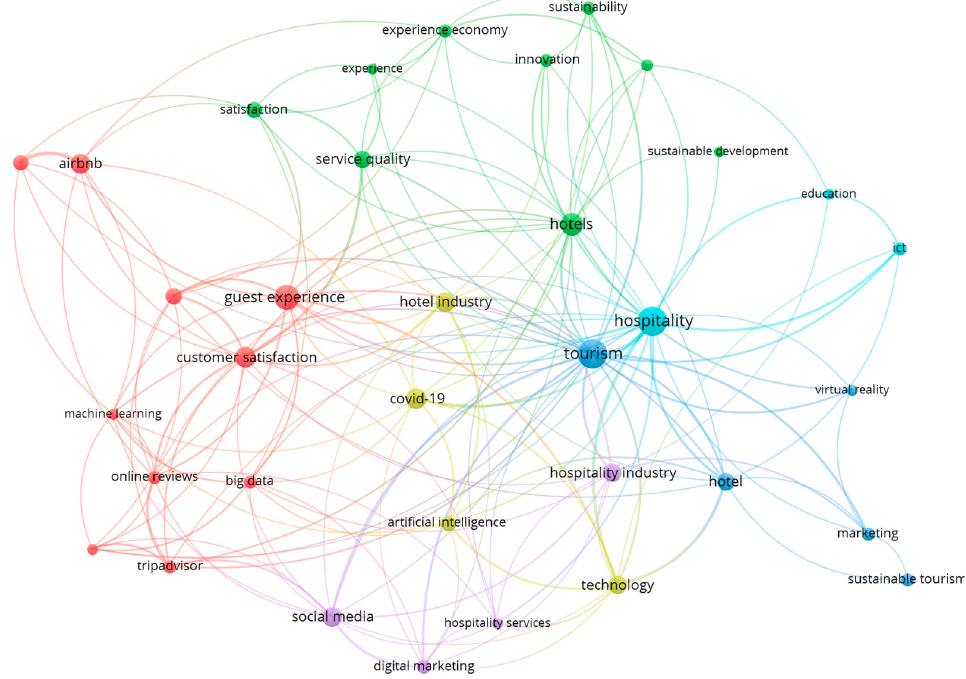
Figure 4. Visualization of the co-occurrence of keywords analysis.